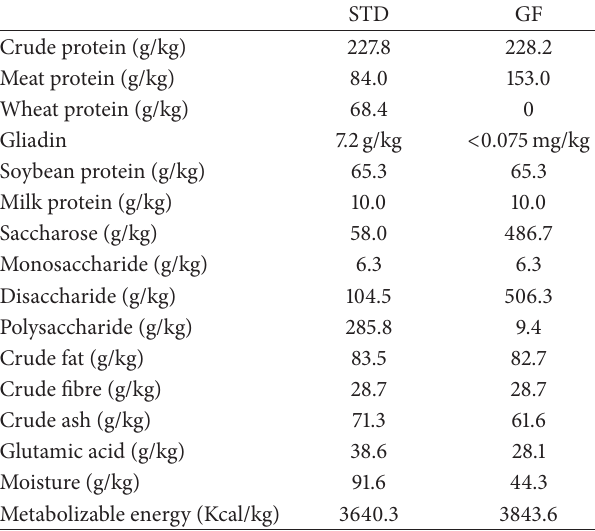
Table 1: Composition of